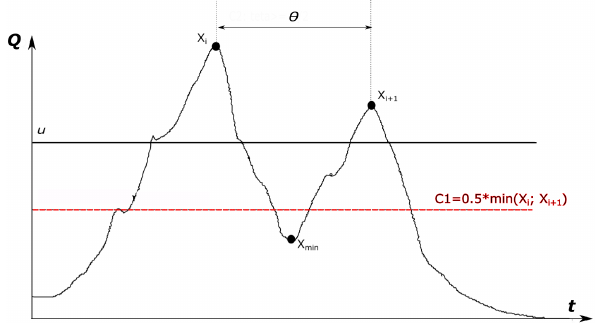
Figure 4. Extraction process of nPOT values. u is the threshold above which all peak are selected; (cid:50) is the time interval between two consecutive nPOT; X min refers to the minimum daily discharge between two consecutive nPOT X i and X i + 1 ; C1 is the minimum threshold between two consecutive nPOT.